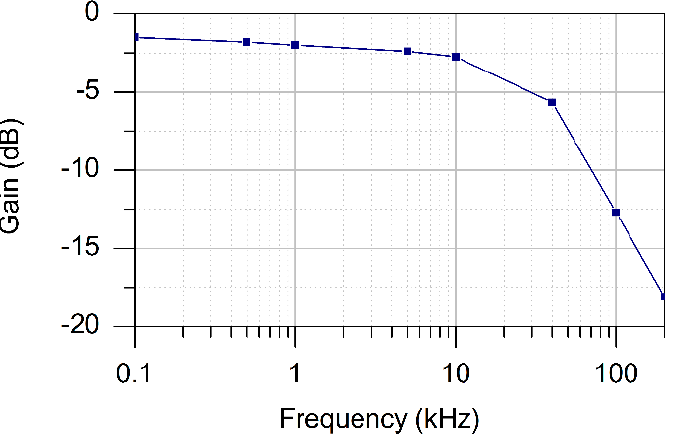
Figure 14. Plot of gain response for the LP filter for experimental results.